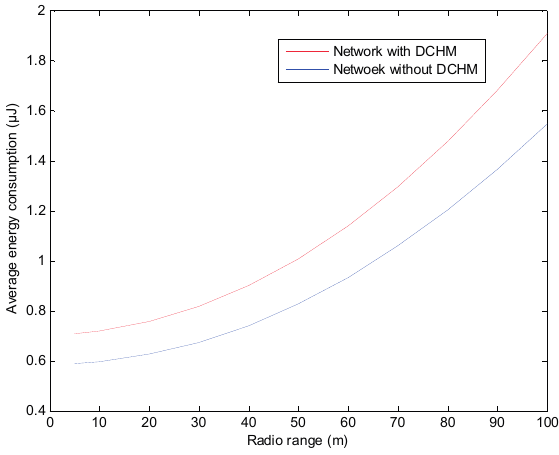
Figure 16. Average energy consumptions versus radio range of a sensor node.